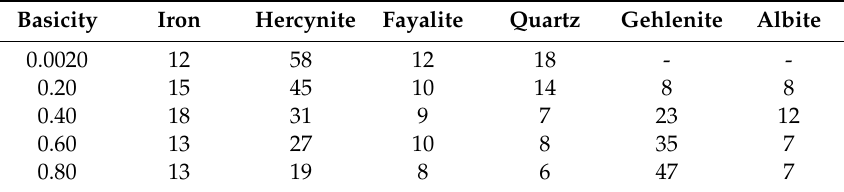
Table 6. The content of main minerals in the Figure 7 (wt.